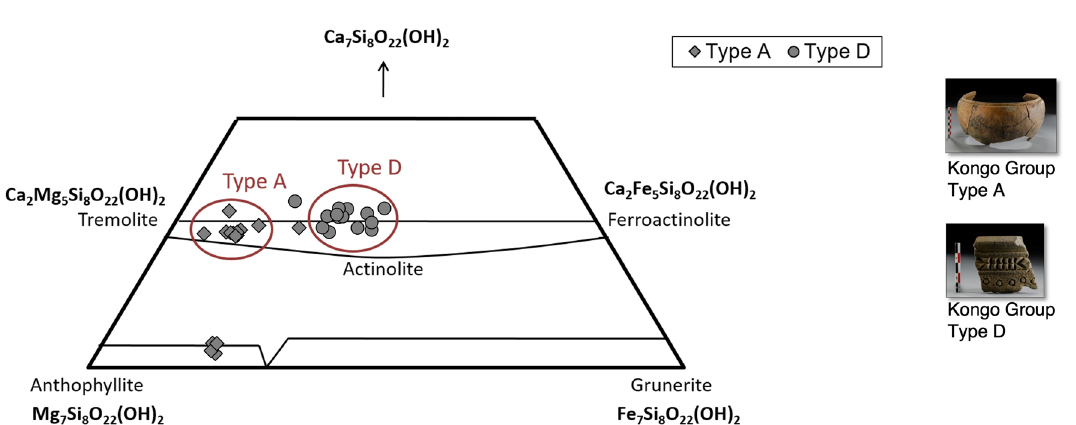
Figure 6. VP-SEM-EDS data. Ternary diagram illustrating the different compositions of amphiboles between Kongo Type A and Kongo Type D pots on selected samples from Mbanza Kongo (MBK), Kindoki (KDK) and Ngongo Mbata (NBC); symbol coded by typological